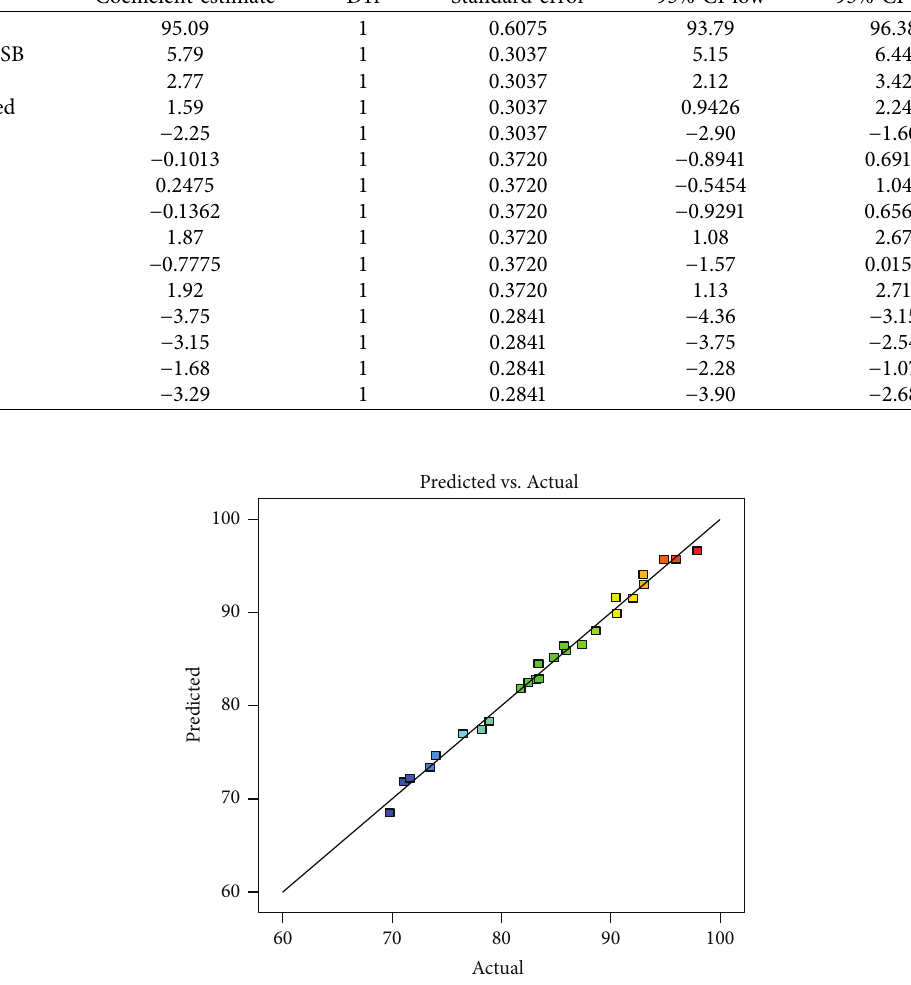
Figure 6: Actual versus predicted values for defluoridation